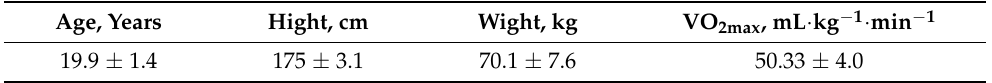
Table 1. Subject Characteristics ( n =